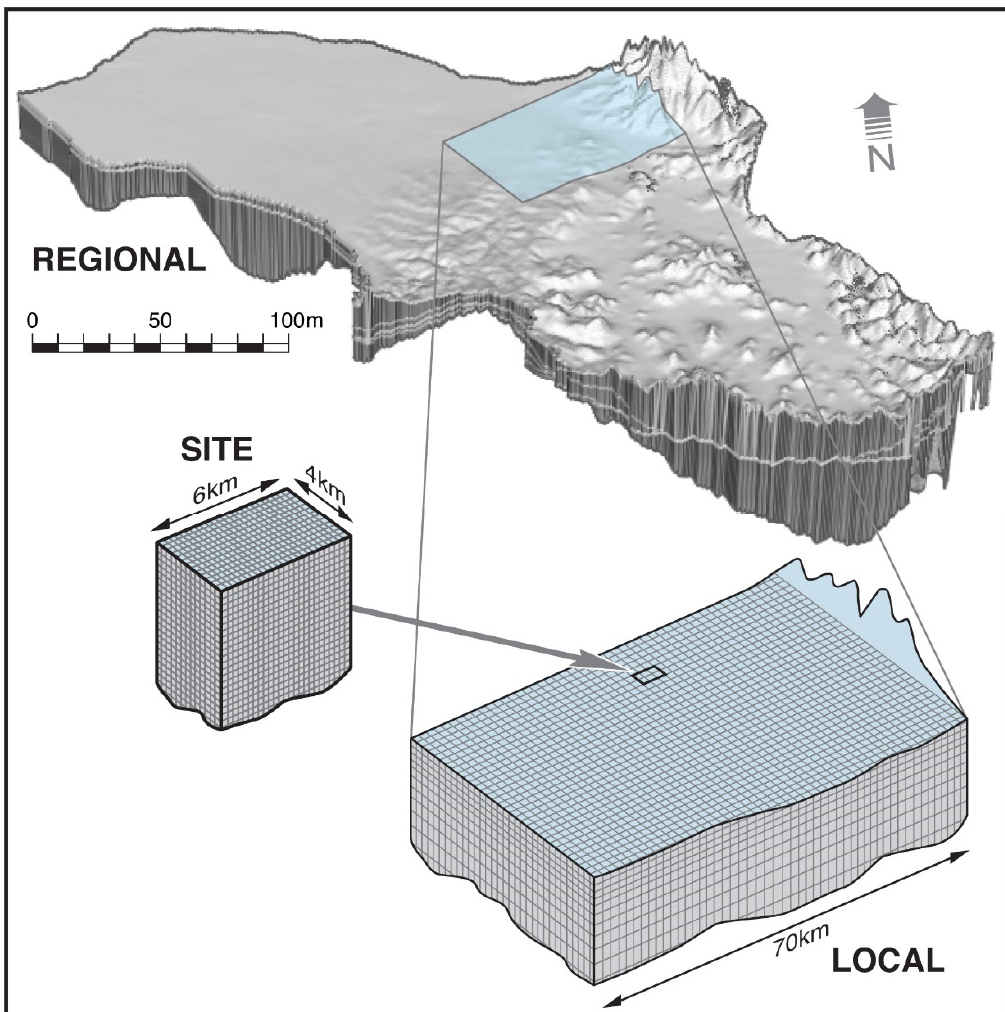
Figure 4. Developing a detailed small-scale site groundwater model (grid cells are 50 × 50 m 2 each) for solute transport simulation within a local (sub-regional) groundwater model (108 km 2 with grid cells of 1 × 1 km 2 each) using the local grid refinement (LGR) method.